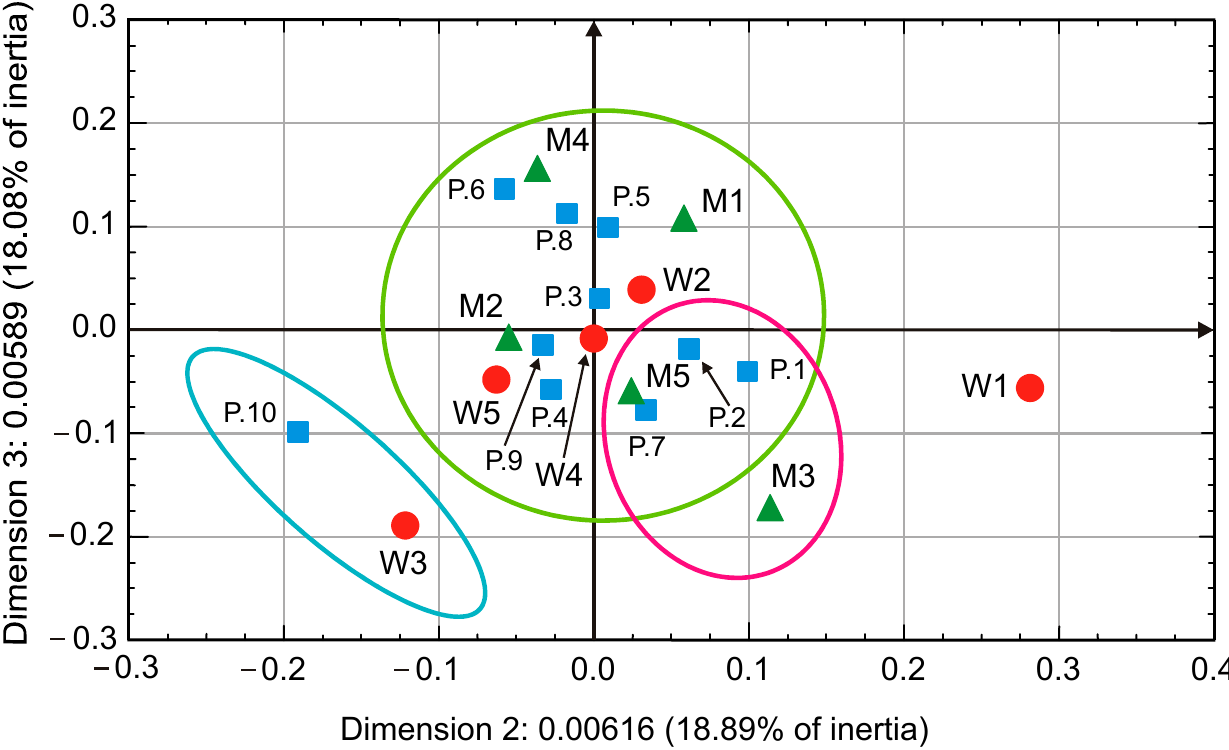
Figure 6. Two dimensional plot of column and row coordinates: dimension 2 × 3. Input table (rows × columns): 10 × 10.